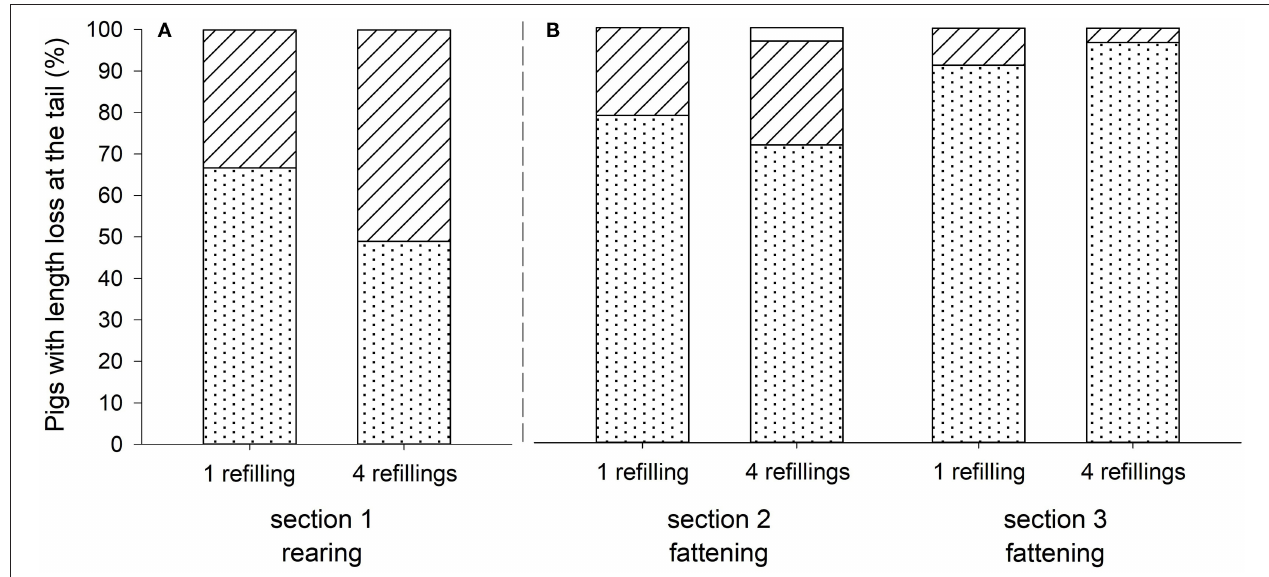
FIGURE 4 | Percentage of pigs without changes (dotted) in length losses ( 1 -tail length), with changes by one score (lined), or by two scores (white) during (A) section 1 in rearing, (B) section 2 and section 3 in fattening. 1 -tail length losses indicate changes in tail length scores within section 1 (rearing), section 2 (first to sixth week of fattening), and section 3 (seventh to eleventh week of